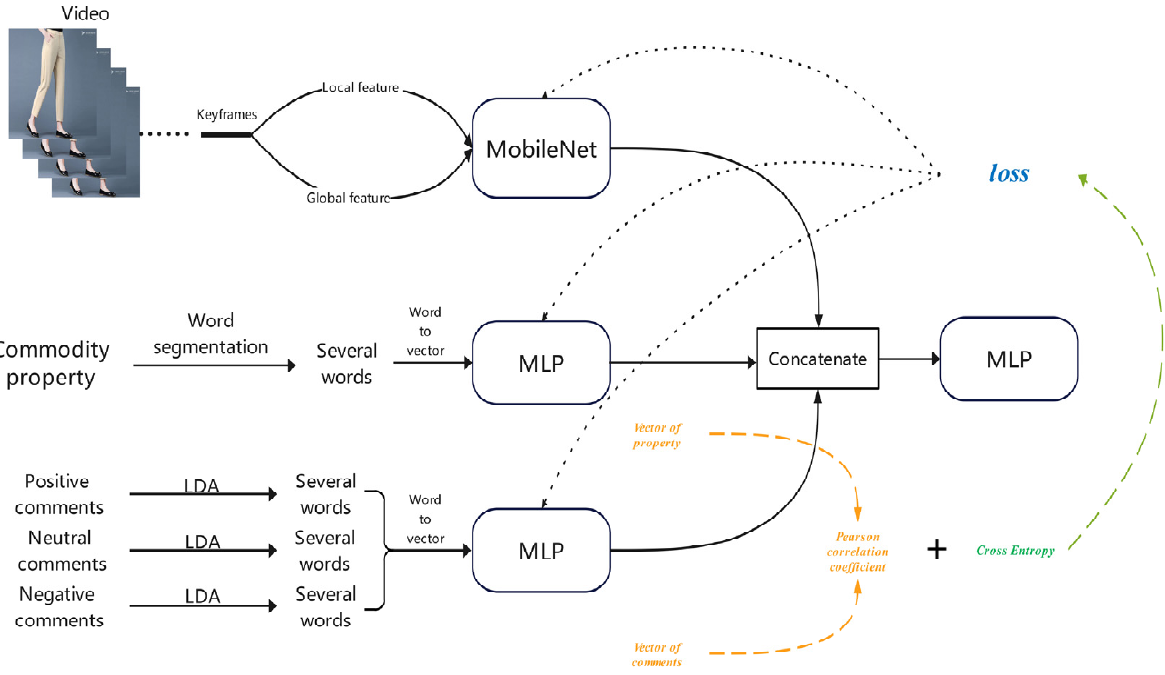
Figure 1. Proposed framework.